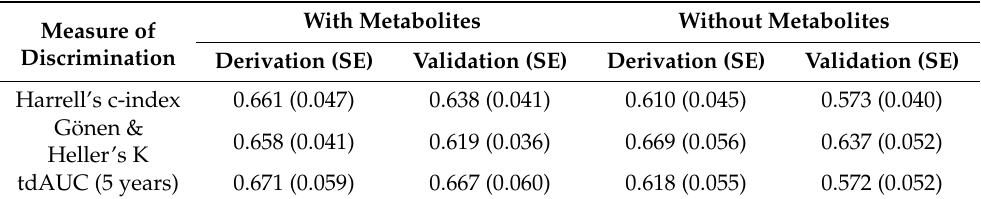
Table 2. Prognostic performance of the models. With Metabolites Without Metabolites Measure of Discrimination Derivation (SE) Validation (SE) Derivation (SE) Validation (SE) Harrell’s